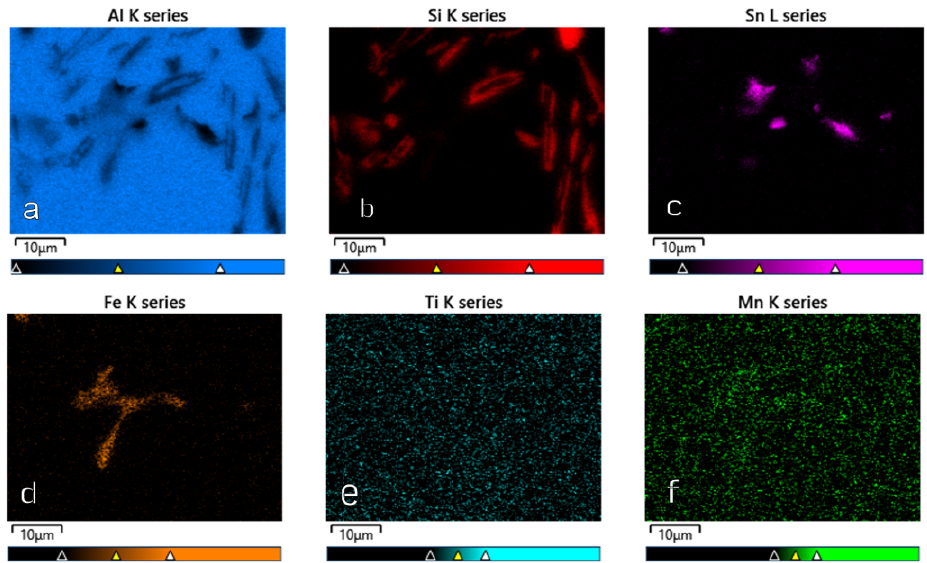
Figure 15. Element distribution maps for AlSi10Sn1.7: ( a ) Al; ( b ) Si; ( c ) Sn; ( d ) Fe; ( e ) Ti; ( f ) Mn.